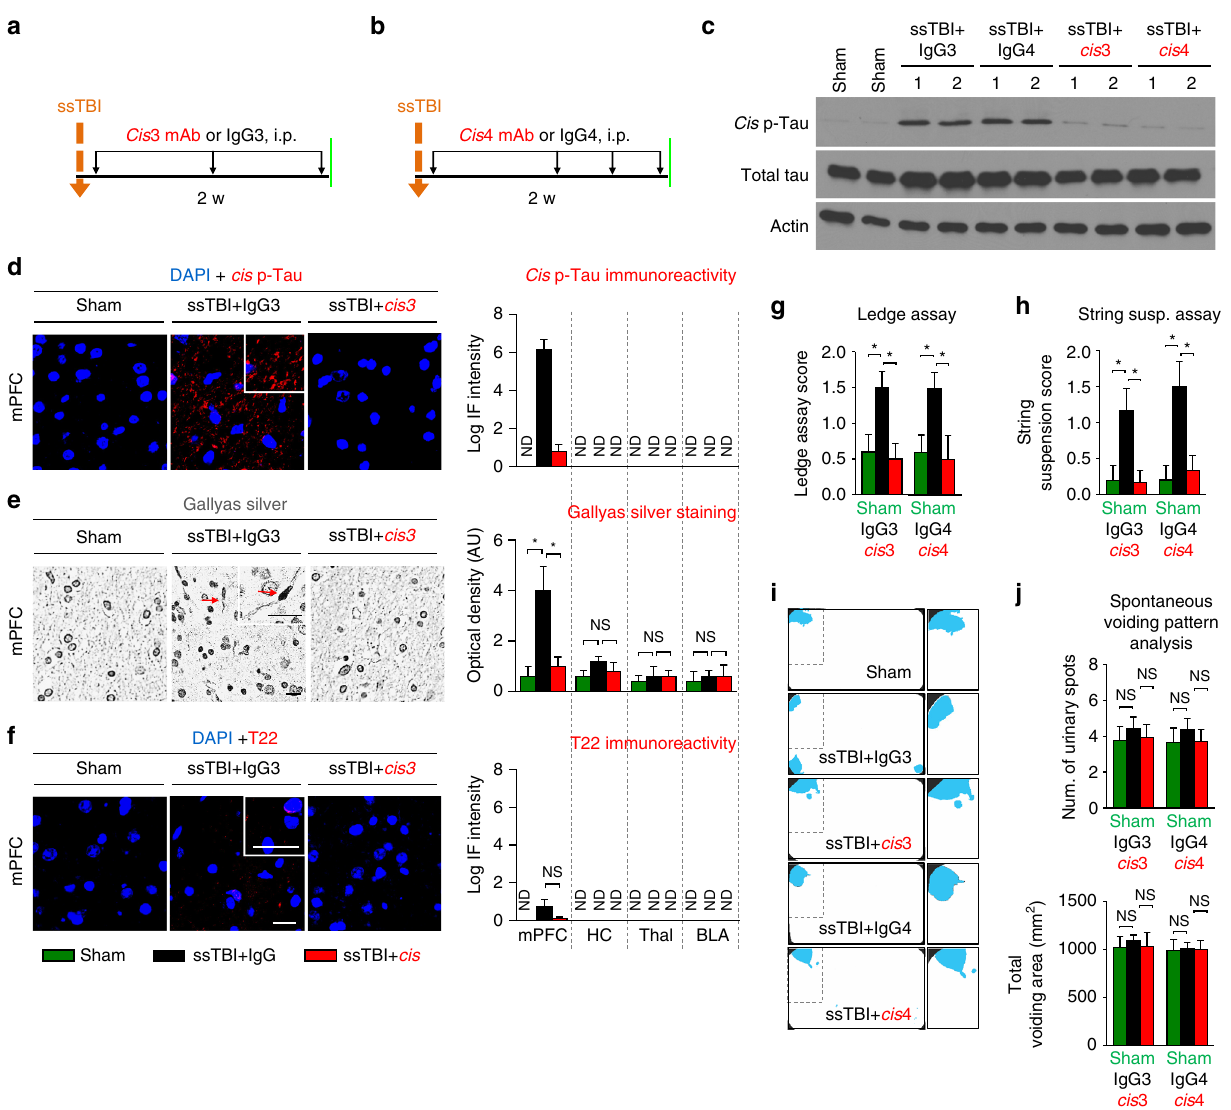
Fig. 4 Eliminating cis P-tau in ssTBI mice with cis mAb prevents a range of pathological and functional outcomes during the acute phases. Mice were subjected to one of two treatment regimens involving 3 or 4 i.p. injections of cis mAb for 2-weeks a , b , followed by functional, biochemical, and pathological examinations. Orange arrows, ssTBI; black arrows, antibody injection; green lines, functional, or pathological assays. Cis mAb treatment of ssTBI mice for 10 days effectively eliminated cis P-tau induction and total tau accumulation, as detected by immunostaining and immunoblotting c , d , restored axonal pathology by Gallyas silver staining e , without any tau oligomerization f , as well as prevented sensorimotor coordination de fi cits, as detected by Ledge assay g and string suspension h at 2 weeks after injury, with no change in urinary pattern at this time (that is, all mice urinated in the corner of cages indicated by blue fl uorescent urine, as expected for normal mice) i , j . Microscope images correspond to the medial prefrontal cortex of sham (left), ssTBI + IgG (middle), and ssTBI + cis mAb (right) with quanti fi cation data in different brain regions being present at right panels. Inset images are the high magni fi cation image of selected area denoted by the white. Scale bar, 40 μ m. Axonal bulb also referred to as a retraction ball indicated with red arrow in Gallyas silver staining. mPFC, medial prefrontal cortex; HC, hippocampus; Thal, thalamus; BLA, basolateral amygdala. ND, not detectable; NS, not signi fi cant. Brains from 4 − 5 WT male mice were studied in immunohistochemistry, 5 − 6 mice underwent urinary pattern test and 9 − 10 WT mice underwent other behavioral studies per group. The data were presented as means ± SEM. The p -values were calculated using unpaired two-tailed parametric Student ’ s t -test. * p < 0.05, ** p < 0.01, *** p < 0.001, **** p <